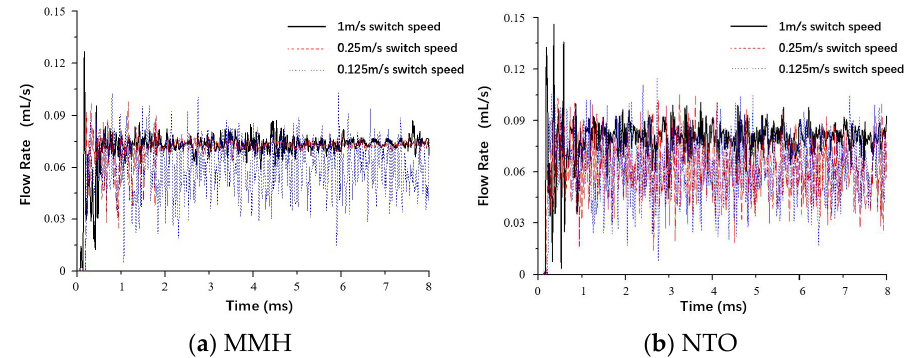
Figure 7. Comparison of MMH ( a ) and NTO ( b ) flowrate fluctuation under different switch speeds, with downstream orifice plate and 0.15 mm stroke.